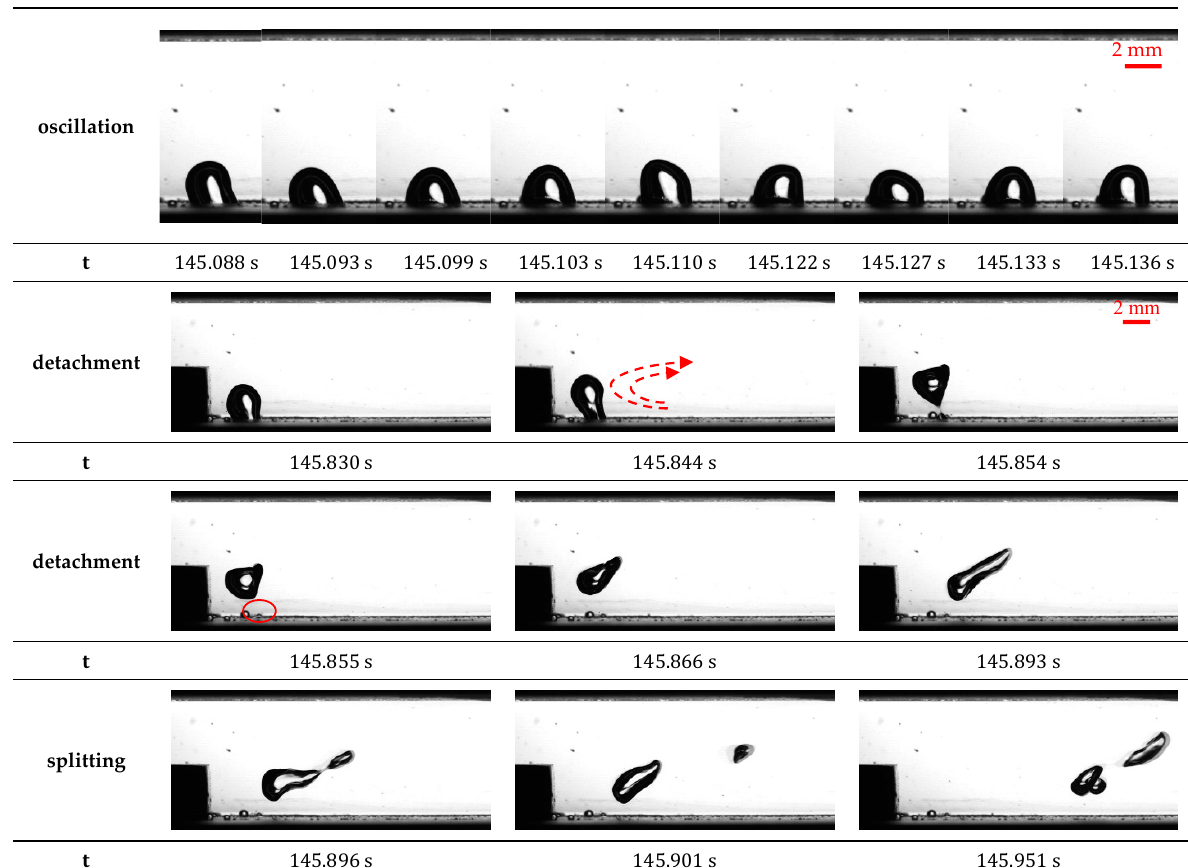
Figure 13. A bubble cycle when Re = 7000 and bubble dynamics.